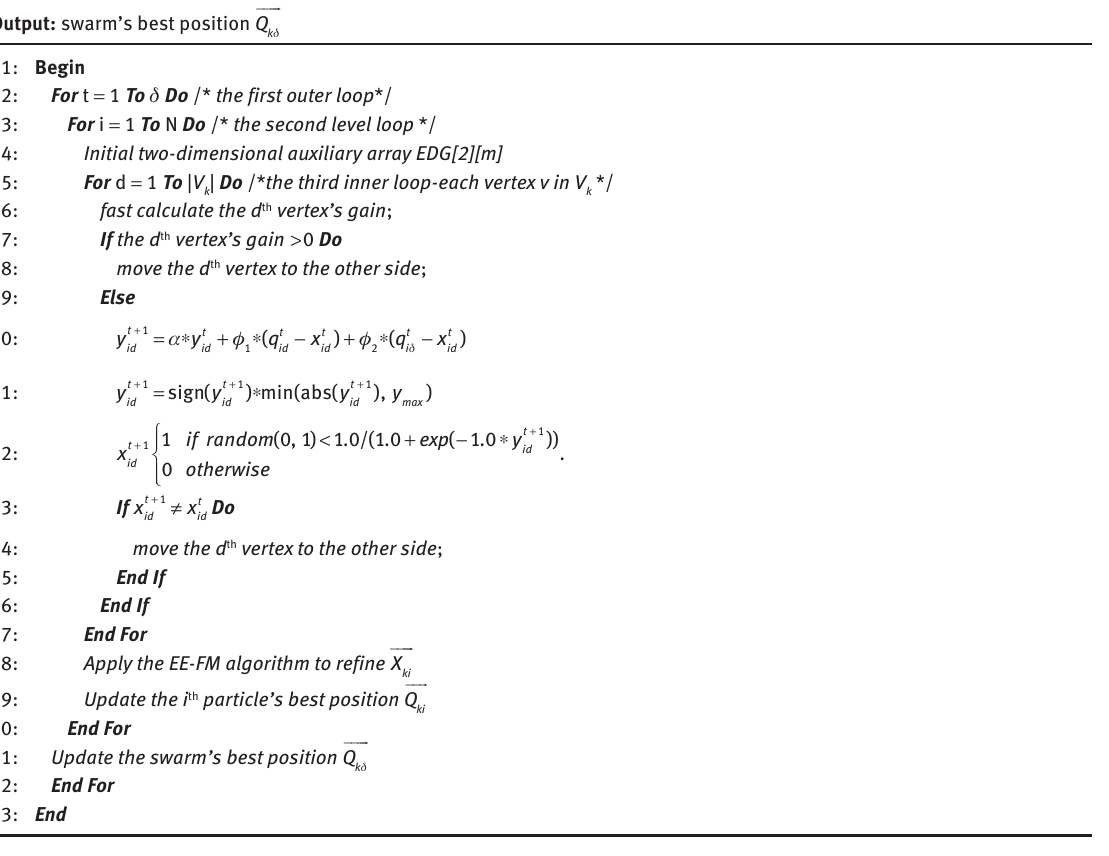
Algorithm 2: The Multi-Level Discrete PSO Refinement